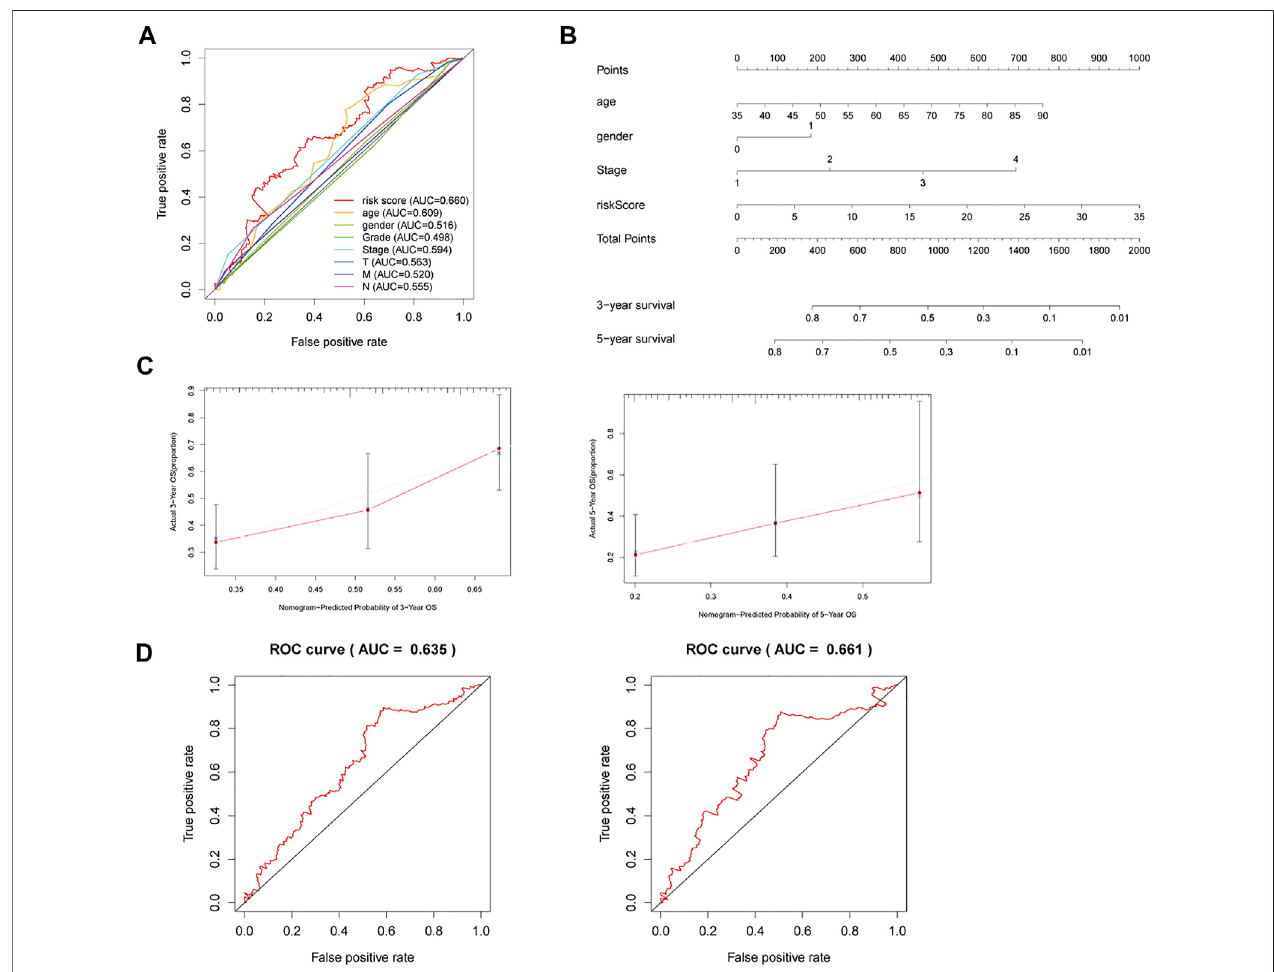
FIGURE4| Anomogramtopredictthree-and5-yearOSforSTADpatients. (A) ROCcurveanalysisofriskscoresandotherclinicalriskfactorsintheentiredataset. (B) Nomogram for predicting three- and 5-year OS in STAD patients. (C) Calibration plots ofthe nomogram for predicting three- and 5-year OS in the entire dataset. (D) Time-dependent ROC curves of the nomogram for predicting OS in the entire